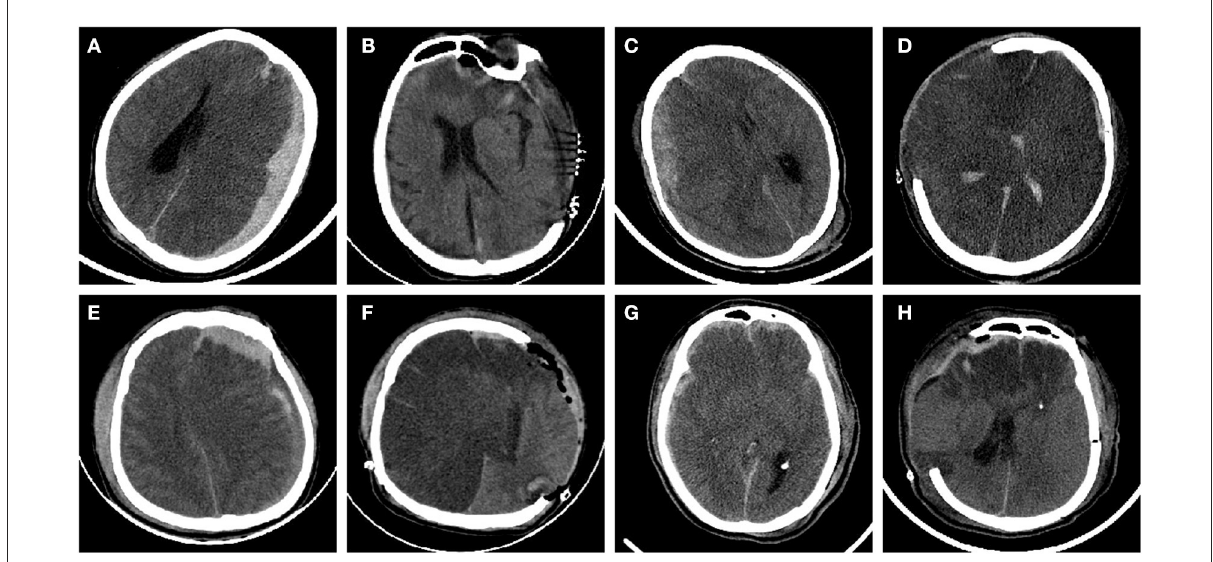
FIGURE1 CT imaging of patients with secondary cerebral infarction after TBI cerebral hernia. (A) Left frontotemporoparietal hematoma after TBI. (B) Hematoma evacuation and decompressive craniectomy showing a left occipital low-density infarction area. (C) Right frontotemporal hematoma with SAH. (D) Decompressive craniectomy showing cerebral hemispheric infarction. (E) Left frontotemporoparietal epidural hematoma with arachnoid hemorrhage. (F) Hematoma evacuation and decompressive craniectomy showed extensive infarction of the right cerebral hemisphere. (G) Frontal lobe laceration, right frontotemporal hematoma, and arachnoid hemorrhage. (H) Postoperative frontal lobe infarction.